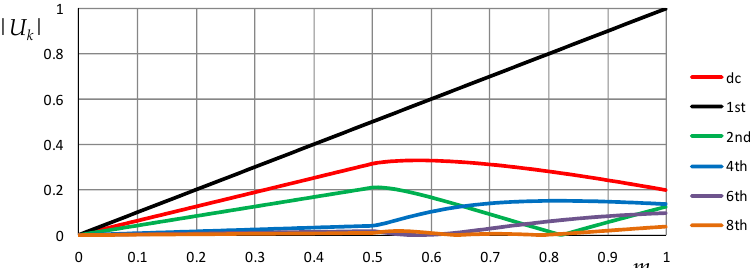
Figure 5. Normalized amplitudes of the low-order H-bridge output voltage harmonics as a function of the modulation index.